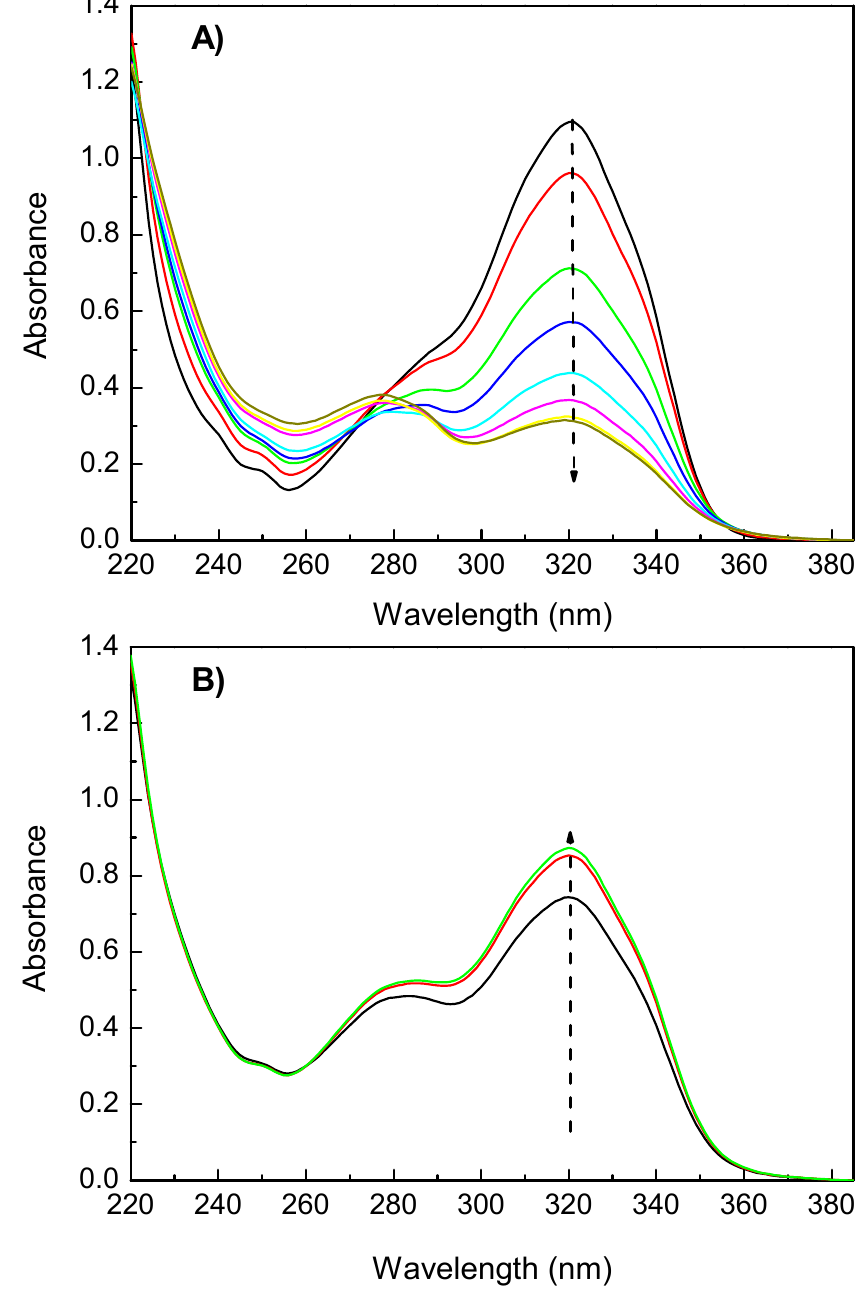
Figure 3 . Photo-dimerization ( A ) and photo-cleavage ( B ) spectra of HEOMC derivative. Figure 3. Photo-dimerization ( A ) and photo-cleavage ( B ) spectra of HEOMC